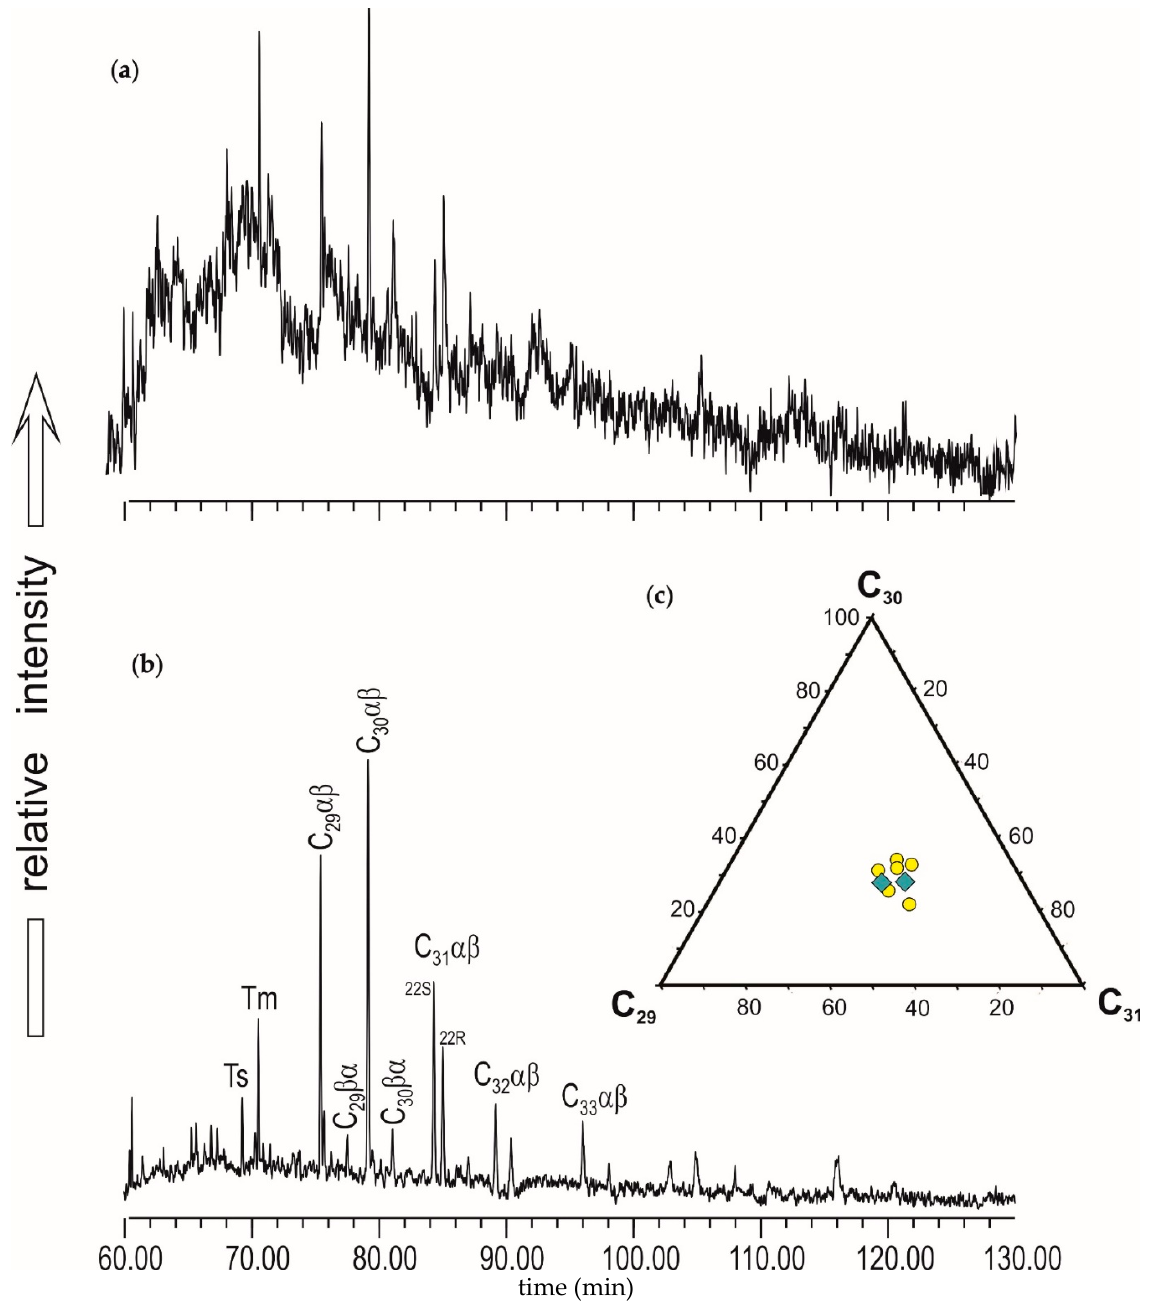
Figure 12. Pentacyclic triterpanes distributions in: ( a ) sample N6; ( b ) sample S3; ( c ) ternary diagram of C 29 ‐ C 30 ‐ C 31 relative percentages. Ts, 18 α (H) ‐ 22,29,30 ‐ trisnorneohopane; Tm, 17 α (H) ‐ 22,29,30 ‐ trisnorhopane; C 29 αβ , 17 α (H),21 β (H) ‐ 29 ‐ norhopane; C 29 βα , 17 β (H),21 α (H) ‐ 29 ‐ norhopane; C 30 αβ , 17 α (H),21 β (H) ‐ 29 ‐ hopane; C 30 βα , 17 β (H),21 α (H) ‐ 29 ‐ hopane; C 31 αβ , 17 α (H),21 β (H) ‐ 29 ‐ homohopane; C 32 αβ , 17 α (H),21 β (H) ‐ 29 ‐ bishomohopane, C 33 αβ , 17 α (H),21 β (H) ‐ 29 ‐ trishomohopane . Yellow circle: N series; blue box: S series.